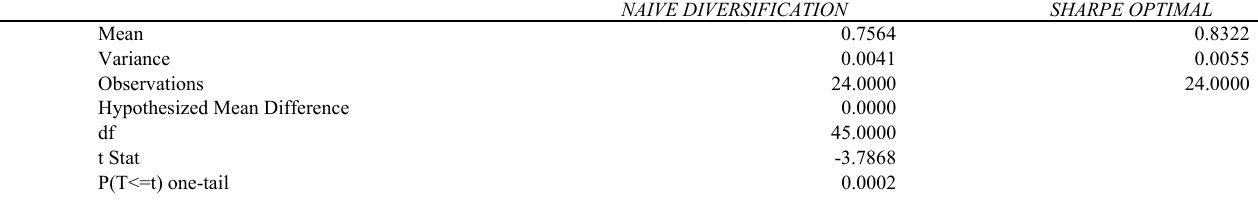
Hypothesis Testing among High Rating Portfolio t-Test: Two-Sample Assuming Unequal Variances